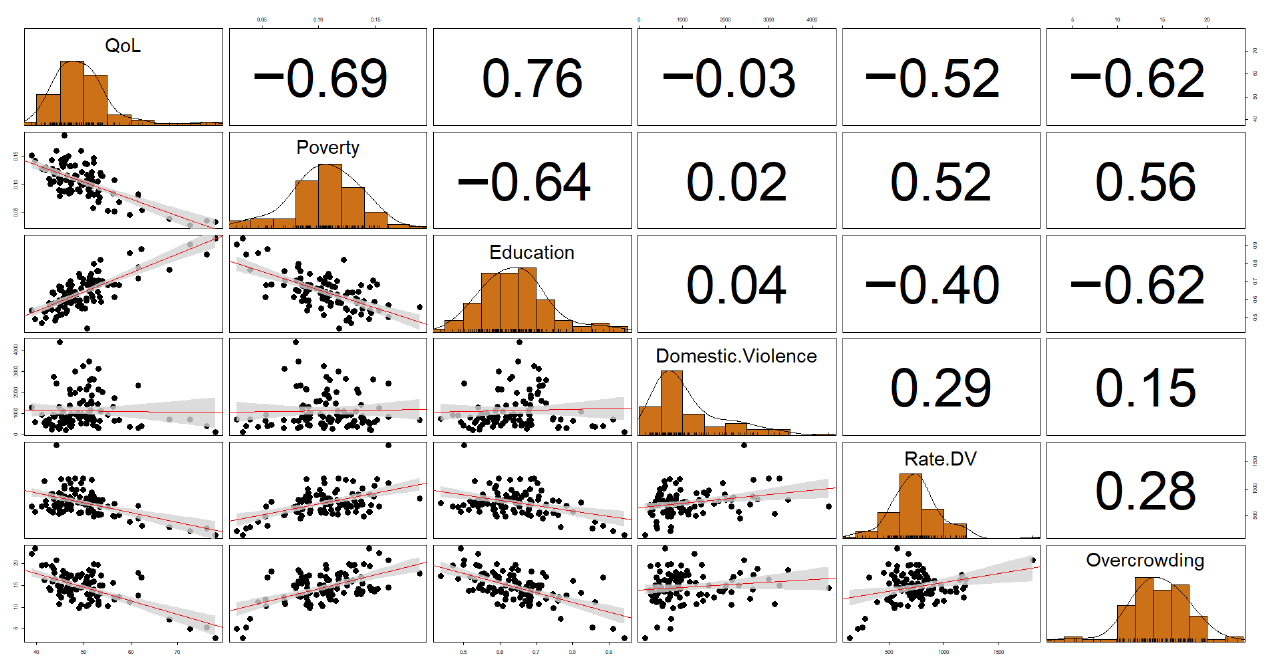
Figure 6. Correlations and scatterplots for quality of life and sociodemographic variables.